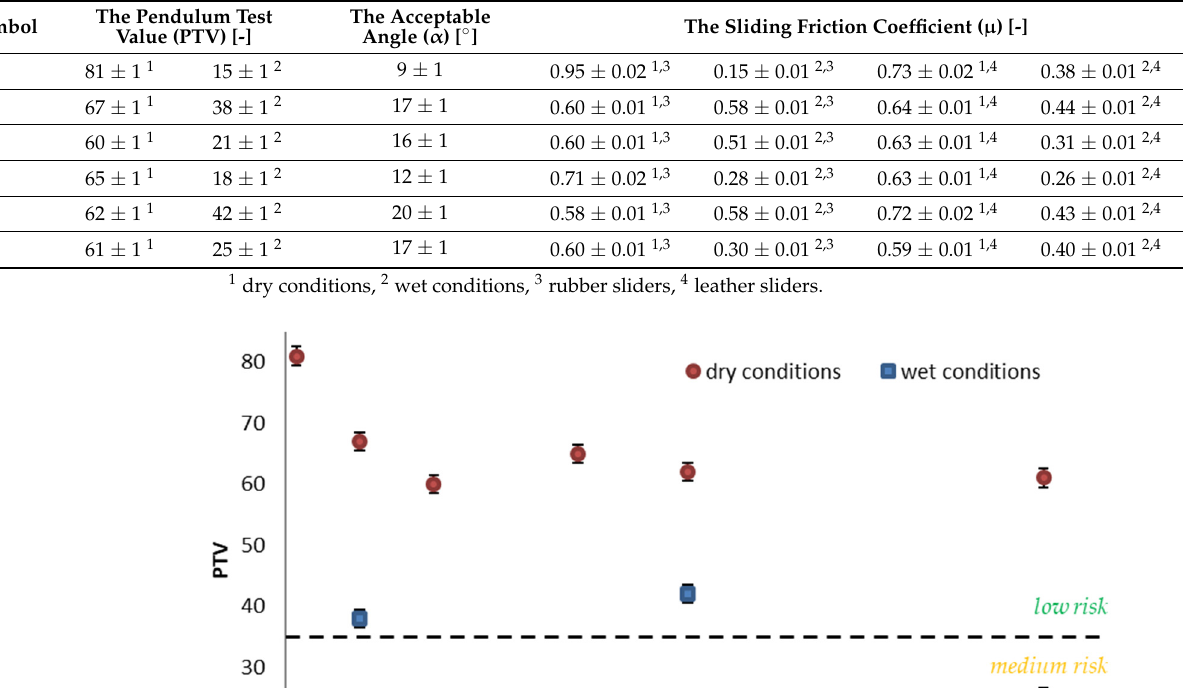
Table 2. The slip resistance tests results.